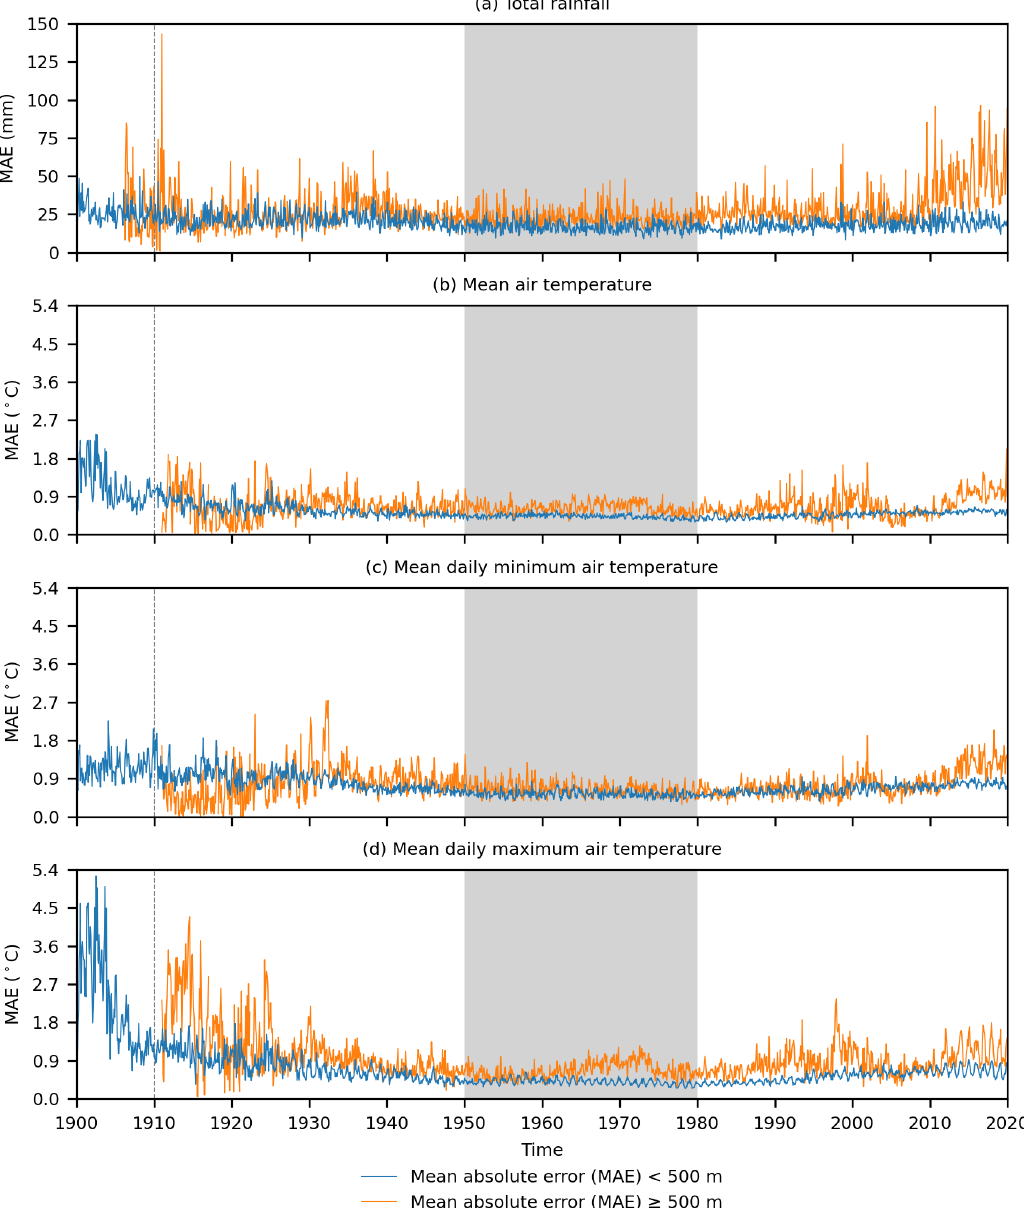
Figure 6. Monthly time series of the cross-validated mean absolute error (MAE) of climatologically aided natural neighbour interpolation across New Zealand at < 500m elevation and ≥ 500m elevation for (a) total rainfall (mm), (b) mean air temperature ( ◦ C), (c) mean daily minimum air temperature ( ◦ C), and (d) mean daily maximum air temperature ( ◦ C). The grey areas show the period (1950–1980) over which the climatologies used to aid interpolation apply, and the dashed lines indicate the temporal limit of reliable